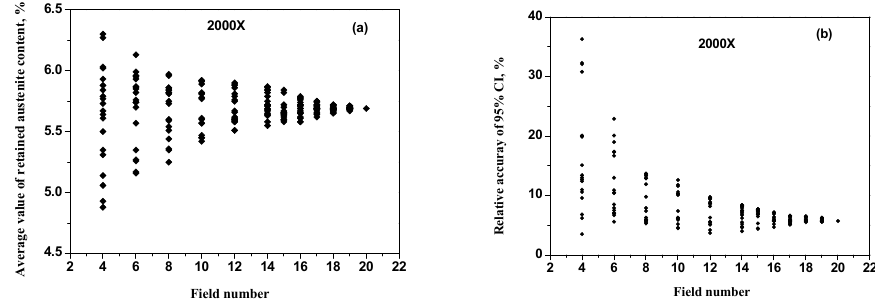
Figure 9. The average value of retained austenite content ( a ) and the relative accuracy of 95% confidence interval ( b ) for different fields.